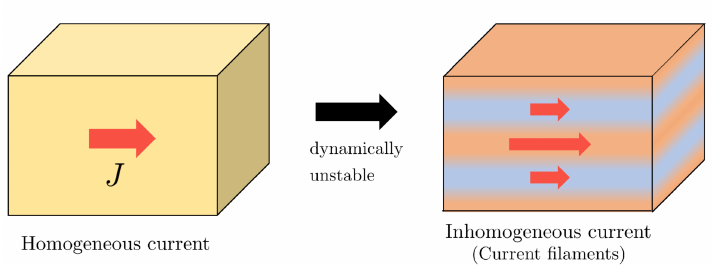
Figure 1 . The schematic of a new branch around the background states in the multivalued region. The system with the homogeneous current becomes dynamically unstable with respect to perturbations. For a finite wavenumber, we find a static perturbation on the background system. This indicates that the system with the spatially modulated current (current filaments) can be